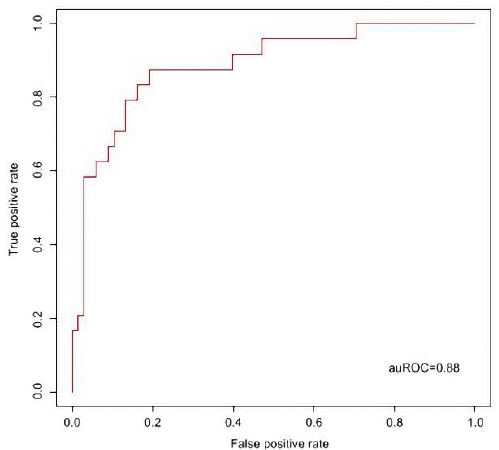
Figure 1. The performance of KD prediction model developed with the conventional laboratory items. Using the values of six conventional laboratory items, we developed a KD prediction model with auROC = 0.88 (95% CI: 0.80, 0.96).